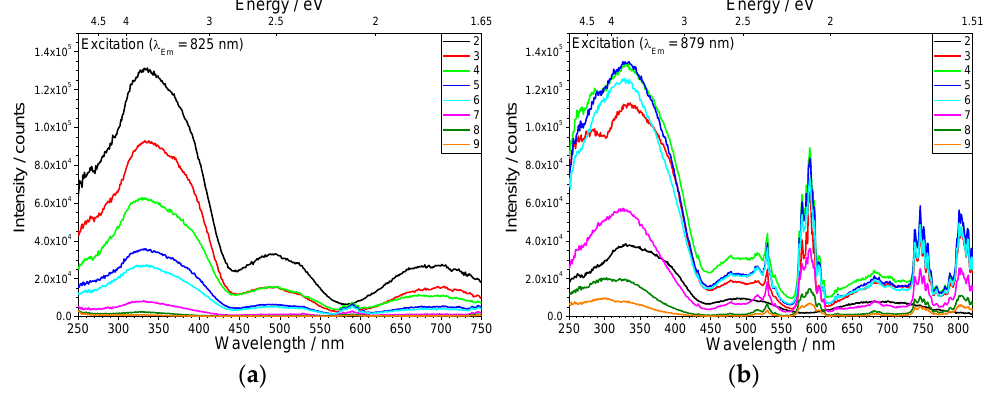
Figure 3. Excitation spectra of Ca 2 MgWO 6 doped with 1% Cr 3+ and (0 – 8)% Nd 3+ and double amount of Li + and Na + ; ( a ) emission monochromator fixed at emission line of Cr 3+ (825 nm), ( b ) emission monochromator fixed at emission line of Nd 3+ (879 nm).